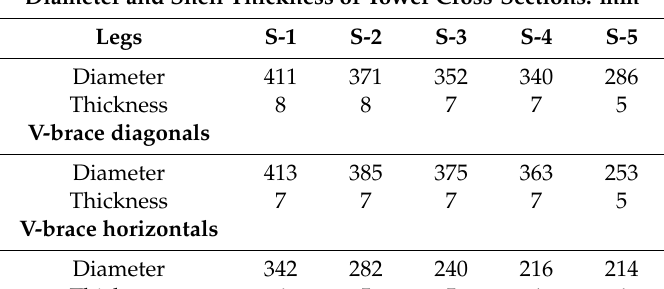
Table 2. Lattice tower cross-section dimensions.